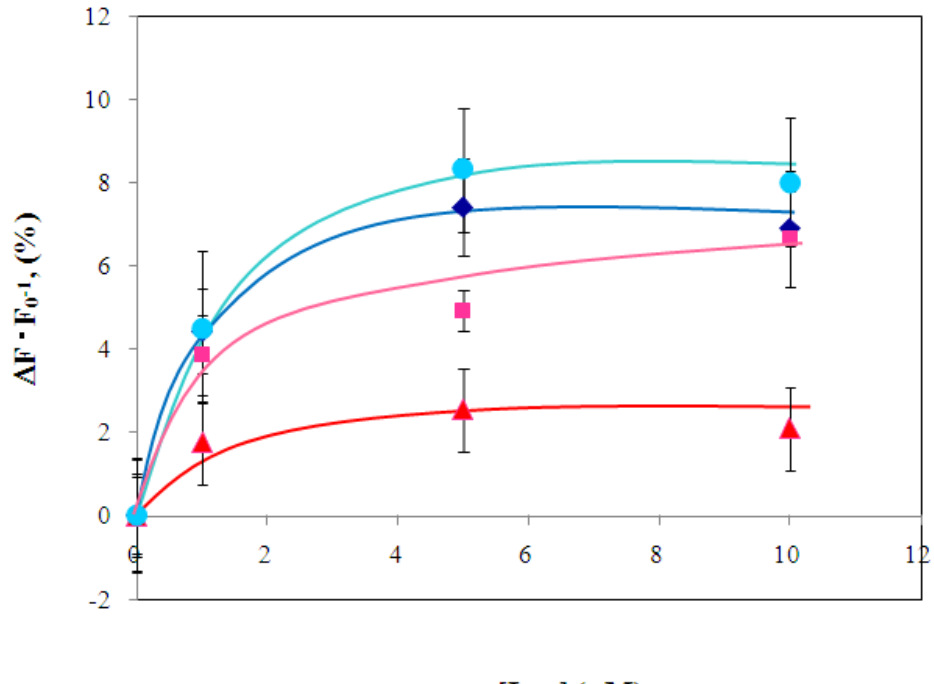
Figure 2. Correlation between fluorescence intensity change and Leu concentration. The autofluorescence intensity changes at 330 nm of wild-type LIVBP (lozenge ♦ ) and its mutants, Gln149Cys (square ■ ), Gly277Cys (triangle ▲ ), and Gln254Cys (circle ● ), were determined at different Leu concentrations. Error bars indicate SD ( n